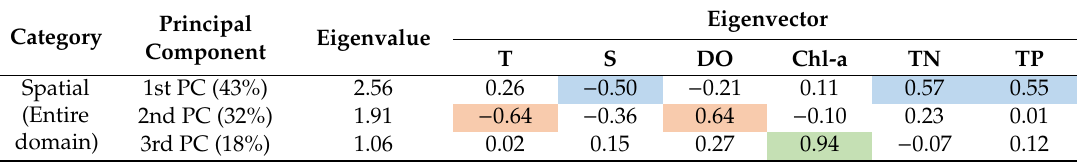
Figure 2. The results of the empirical orthogonal function (EOF) corresponding to the ( a ) 2D and ( b ) 3D principal components (PCs) for the spatial distribution. The sky blue, orange, and light green mean a group of variables that contribute to the first PC, second PC, and third PC, respectively.